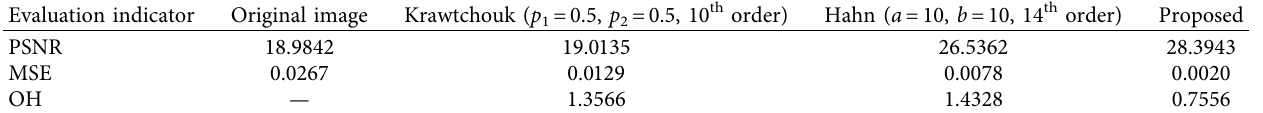
Table 3: Comparison of different reconstruction algorithms.